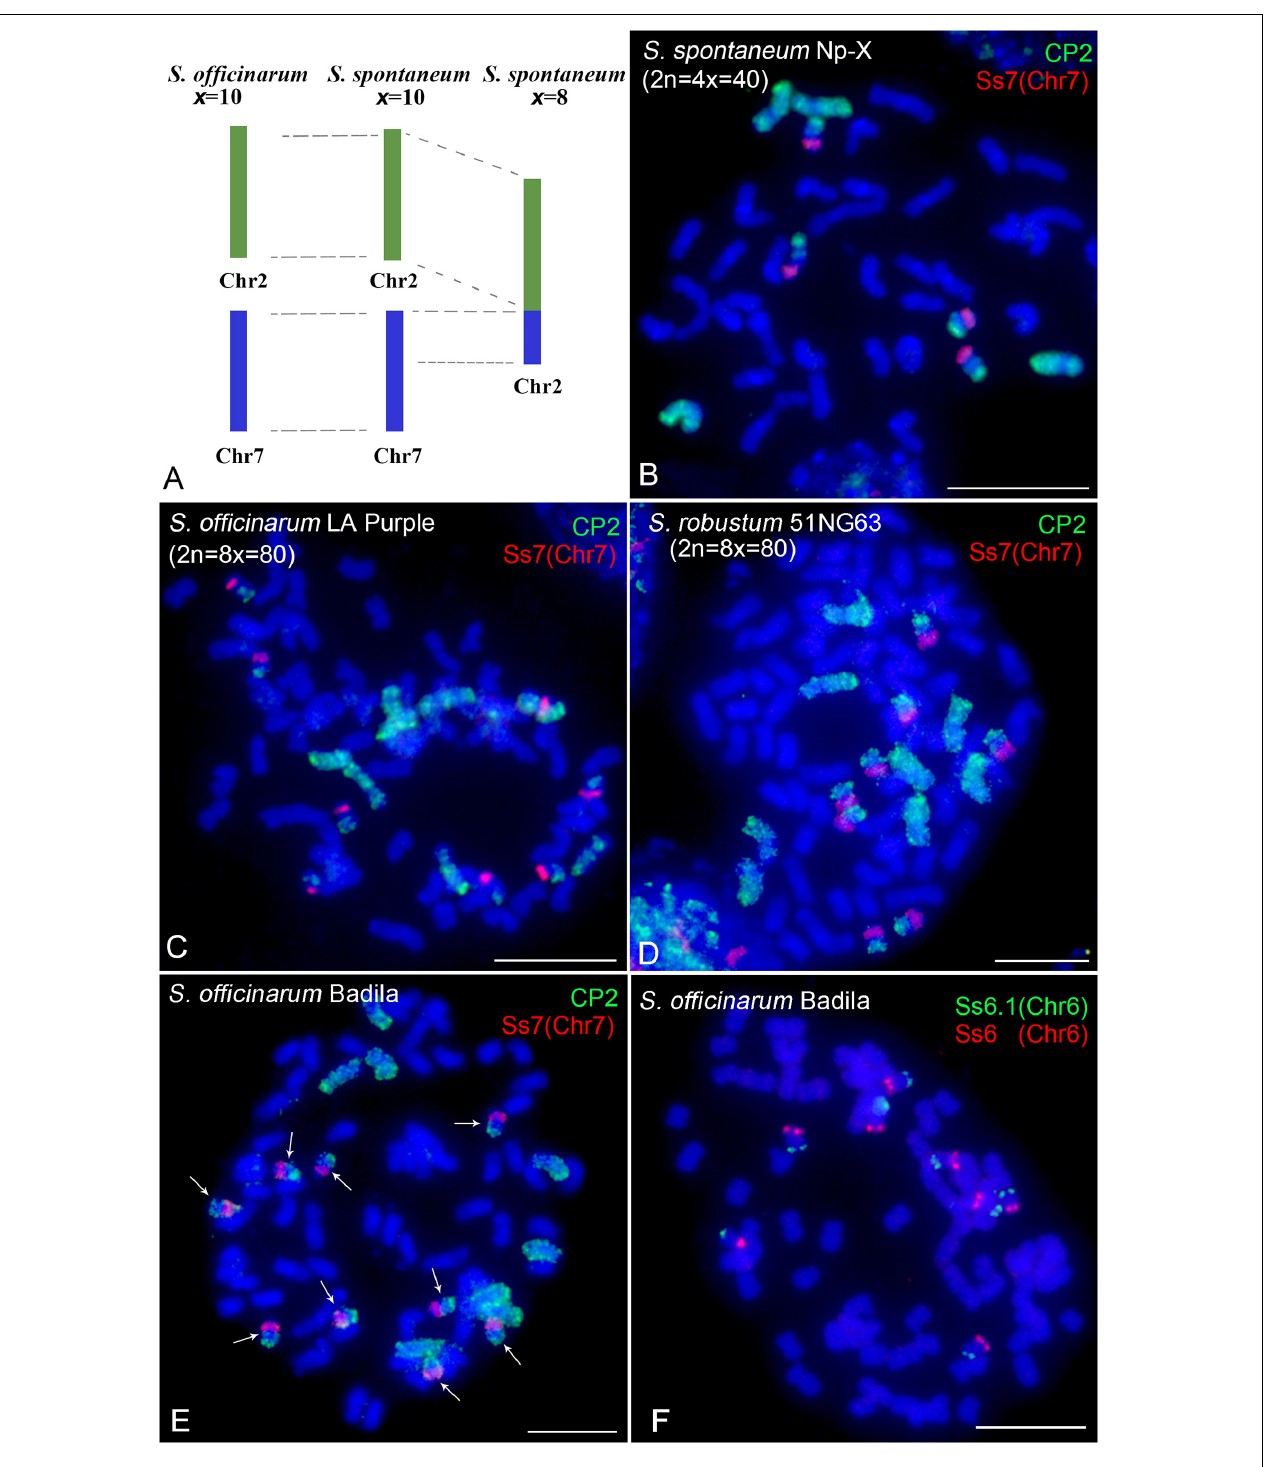
FIGURE 5 | Cross-species chromosome painting assay in Saccharum . (A) Illustration of chromosome rearrangement between S. officinarum and S. spontaneum . Chromosome 2 in the S. spontaneum clone with the basic chromosome number of x = 8 was derived from a fusion of chromosome 2 and a fragment of chromosome 7 in S. officinarum and S. spontaneum with the basic chromosome number of x = 10. (B–D) Dual-color FISH using CP2 and the chromosome 7-specific probe Ss7 in S. spontaneum Np-X (2n = 4x = 40) (B) , S. officinarum LA Purple (2n = 8x = 80) (C) , S. robustum 51NG63 (2n = 8x = 80) (D) , and S. officinarum Badila (E) . Arrows indicate the nine copies of chromosome 7. (F) Dual-color FISH using chromosome 6-specific probes Ss6.1 and Ss6 in S. officinarum Badila. Scale bars, 10 µ m.